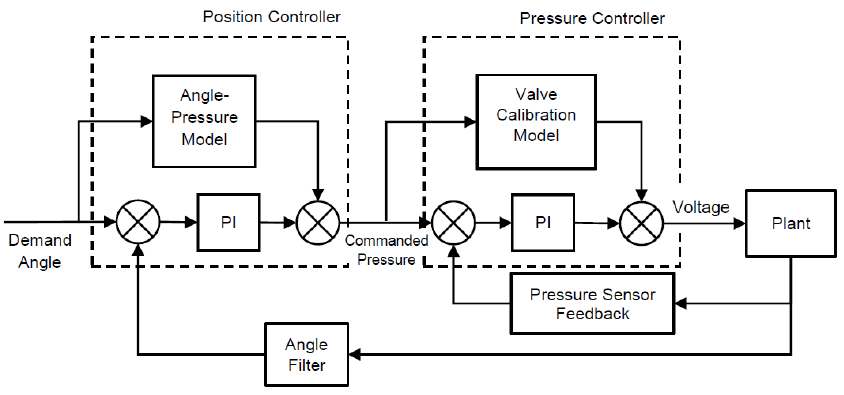
Figure 10. Block diagram of the designed closed-loop controller.